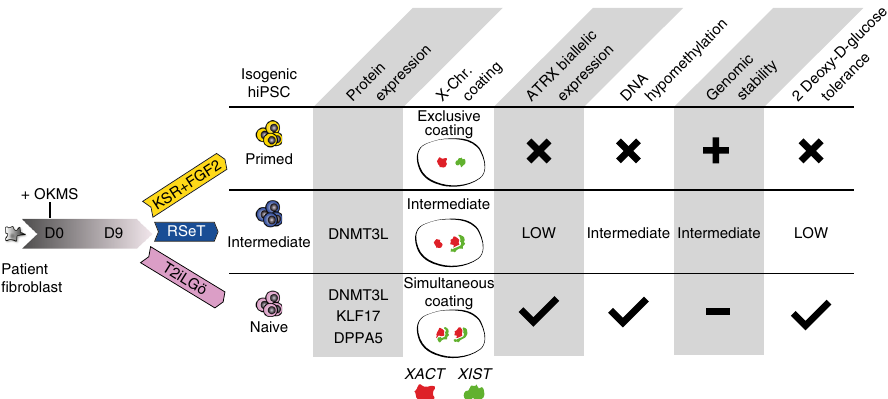
Fig. 7 hiNPSCs in T2iLGö achieve the most naive pluripotency hallmarks. The presented reprogramming method enables to simultaneously generate isogenic hiPSCs in KSR+FGF2, RSeT and T2iLGö media. The naive pluripotency level of the generated cell lines can be assessed with speci fi c markers, X- chromosome activity status, DNA methylation level and capacity to tolerate glycolysis